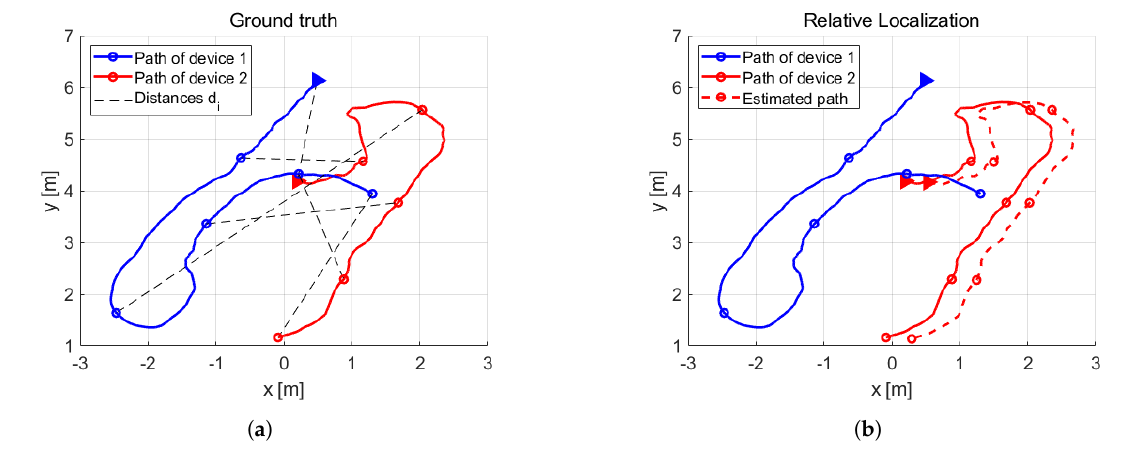
Figure 10. Several subsets of the measured data are selected in order to validate our method. ( a ) Ground truth paths of each device and the selected distance measurements. ( b ) Comparisson of the estimated path of device 2 with the ground truth.